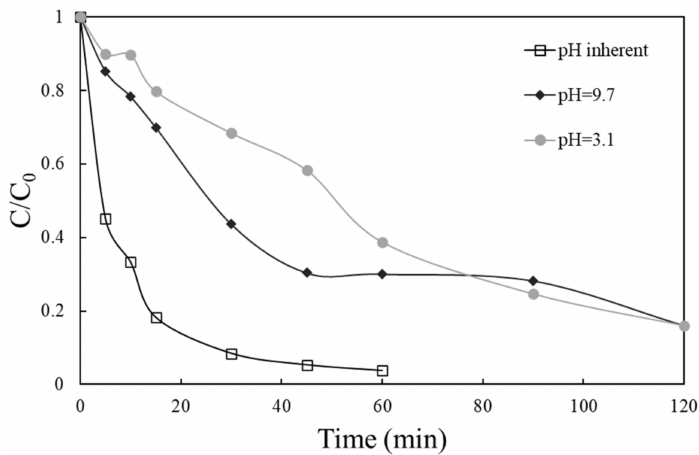
Figure 9. Effect of initial pH solution on the degradation of 0.5 mg/L VLS with 1000 mg/L 0.25 MoS 2 /BiOCl in